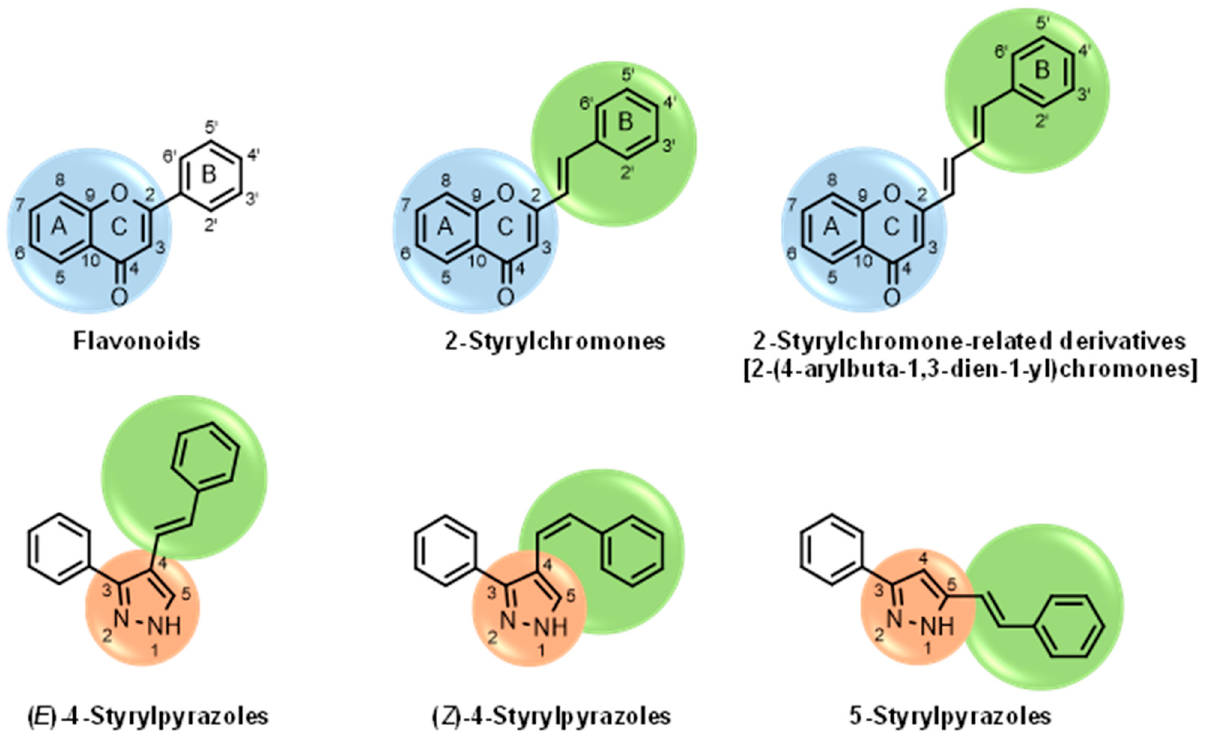
Figure 2. General chemical structures and numerical representations of the tested chromone derivatives, flavonoids, 2-styrylchromones, and 2-styrylchromone-related derivatives [2-(4-arylbuta-1,3-dien-1-yl)chromones], and 4- and 5-styrylpyrazoles. The chromone core is represented in blue, the styryl group is represented in green, and the pyrazole core in orange.